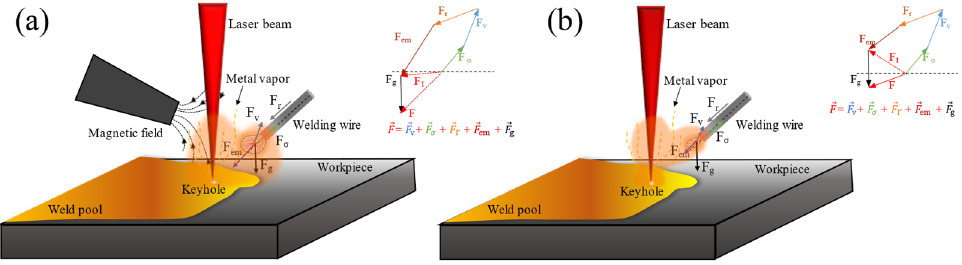
Figure 12. Force analysis of droplet transfer: ( a ) with magnetic field and ( b ) without magnetic field.